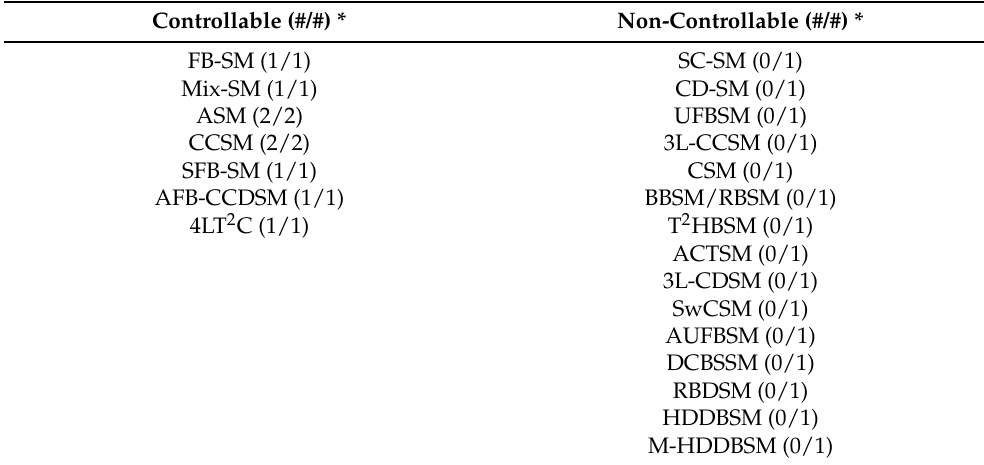
Table 6. Classification of SMs based on negative voltage controllability. Controllable (#/#) * Non-Controllable (#/#)